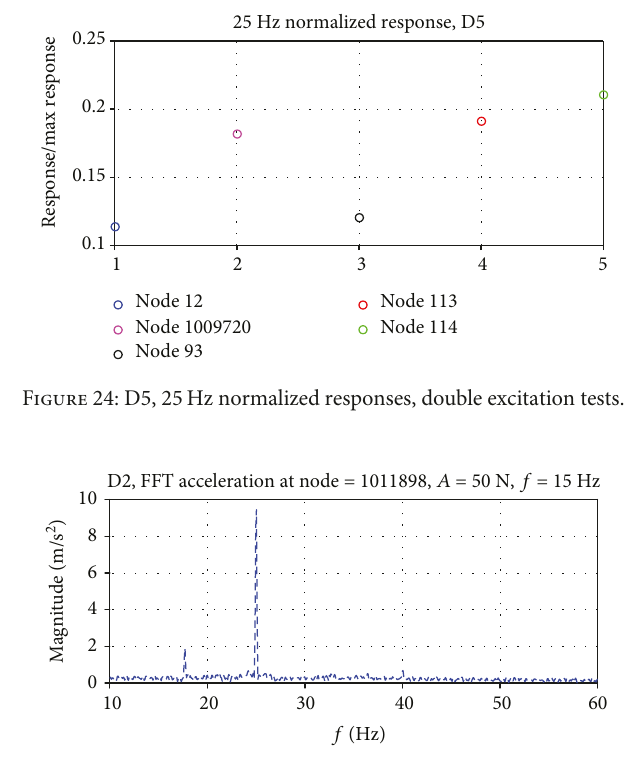
Figure 25: D2, direct response FFT, 15Hz excitation test.